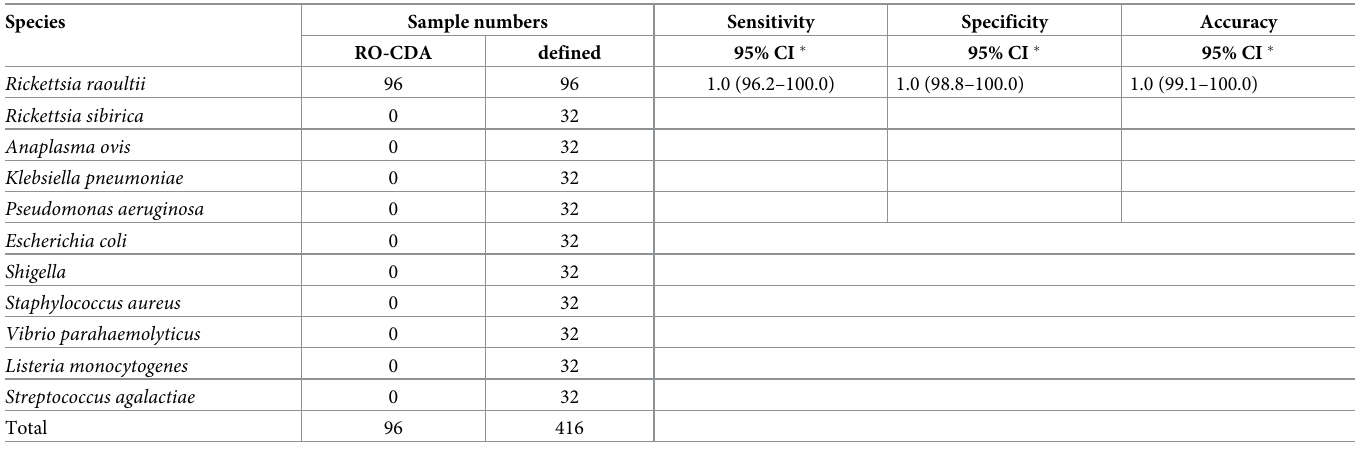
Table 3. Determination of sensitivity and specificity of RO-CDA assay for Rickettsia raoultii